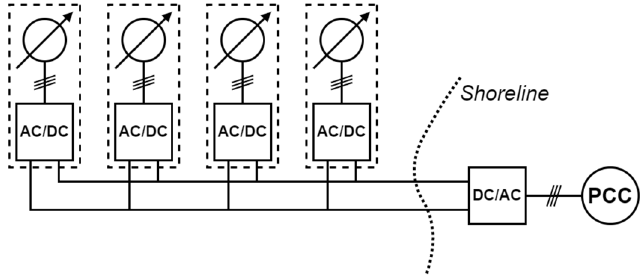
Figure 19. Topology T1. A parallel-connected DC collection grid without separate boosting steps.